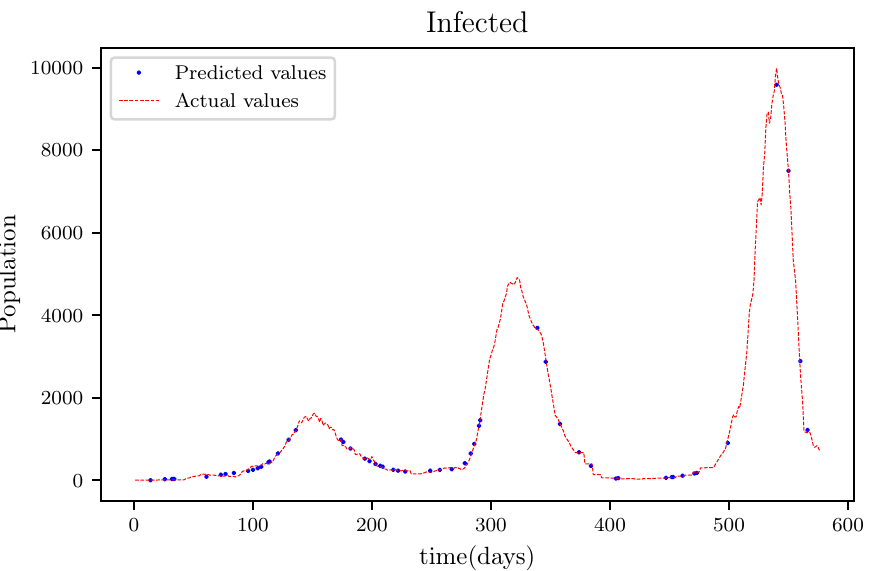
Figure 11. This graph shows a comparison of the predicted values of susceptible population and the actual data of susceptible population for a 130 data points.